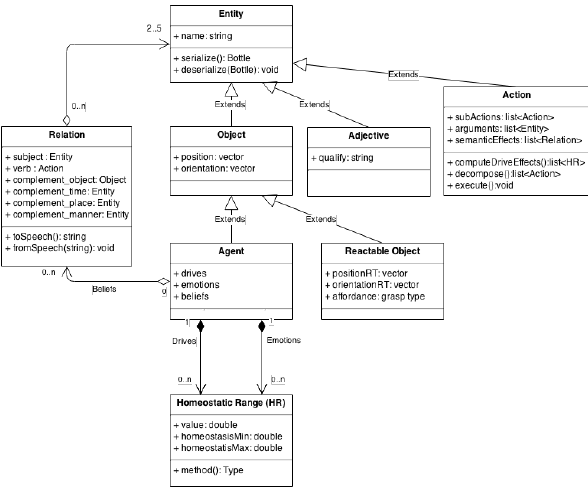
Figure 4: Simplified class diagram of the Knowledge Representa- tion defined by WR-DAC. Entities solve the anchoring problem, by formalizing elements of the world, grounding a sensorimotor rep- resentations at the somatic level to an abstract representation in the form of a manipultable concepts, for which semantic classes are directly mapped to programming types. Relations link an object (subject), and an action (a verb) and up to four other entities (com- plements) as to represent a solution to the H5W problem. Moreover, relations have a direct mapping with spoken language and can be used to represent the beliefs of an agent and its perceived world